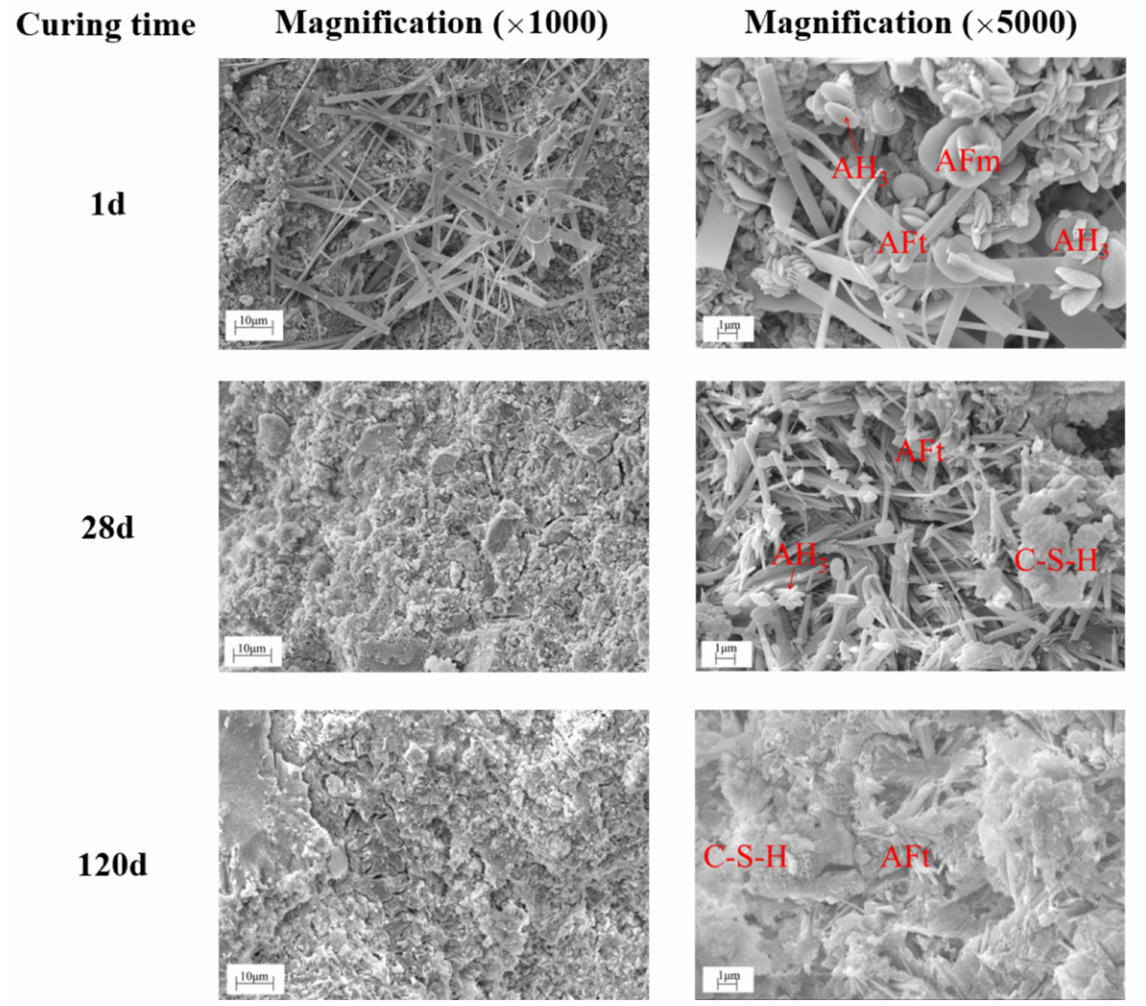
Figure 13. SEM images of the CSAC-GGBFS mixture with 6% FGDG hydrated for different time